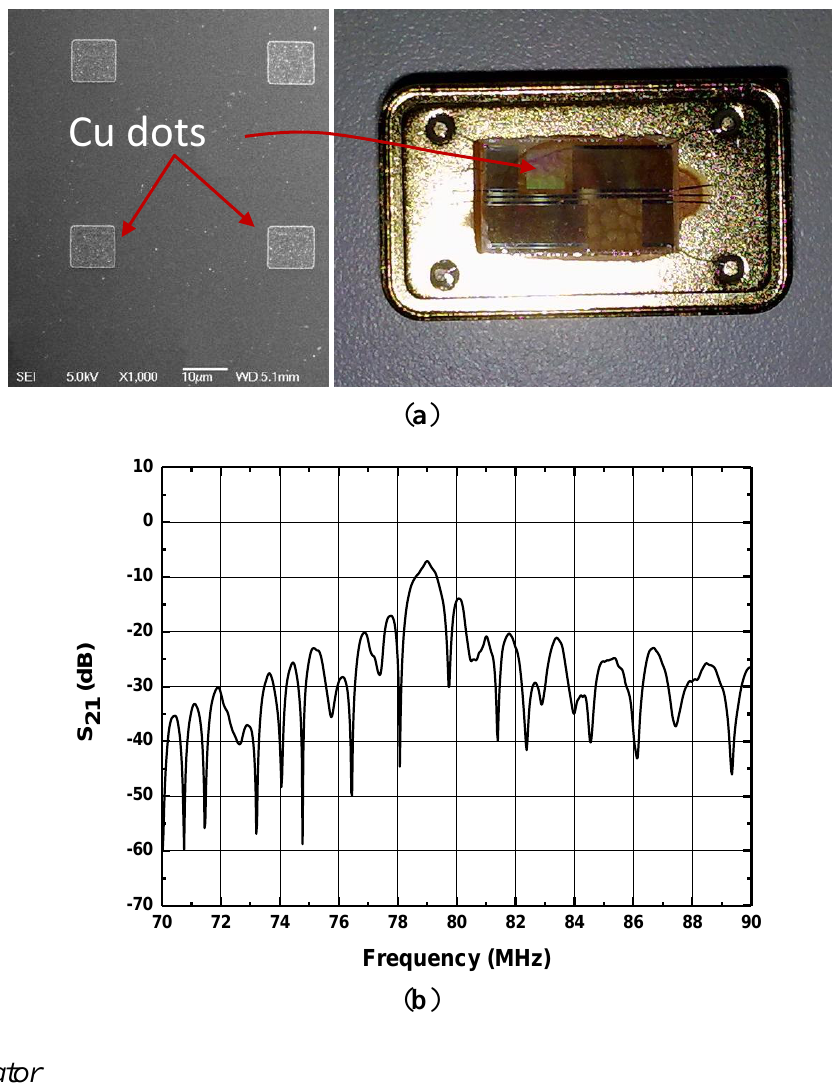
Figure 5. The fabricated SAW delay lines ( a ) and measured frequency response of the fabricated devices ( b